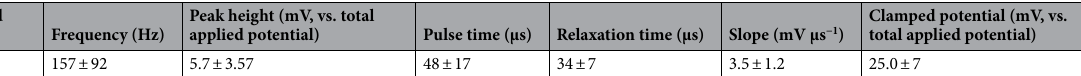
Peak height (mV, vs. total applied potential)